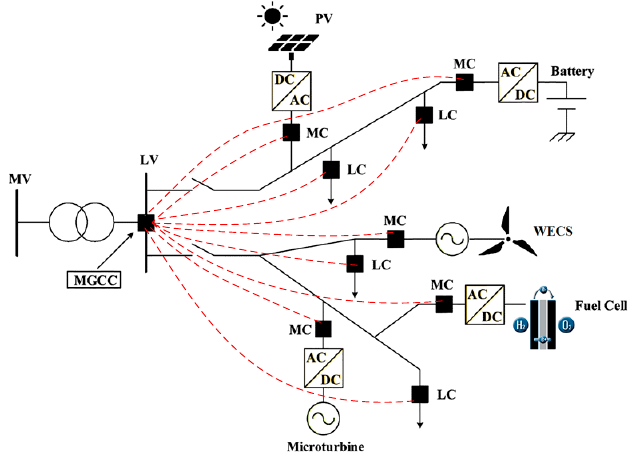
Figure 1. Typical low voltage (LV) microgrid (MG). MGCC: microgrid central controller; MC: microsource controller; LC: load controller; WECS: wind energy conversion system; PV: photovoltaic.